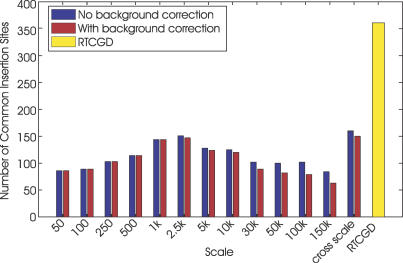
Number of CISs per Scale ParameterNumber of CISs for Various Scale Parameters (Corrected and Uncorrected), the csCISs, the Background-Corrected csCISs, and the CISs from the RTCGD. Background correction only has effect at larger scales.